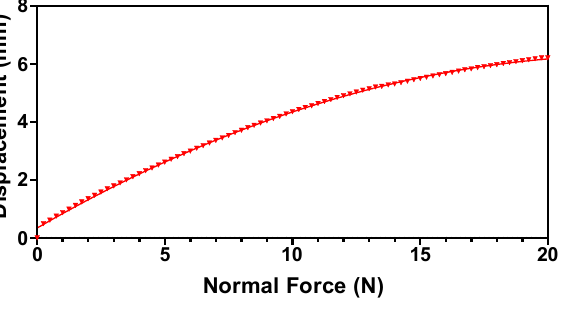
Figure 10. The displacement profile of the proposed tactile sensor for an input normal force range up to 20 N.